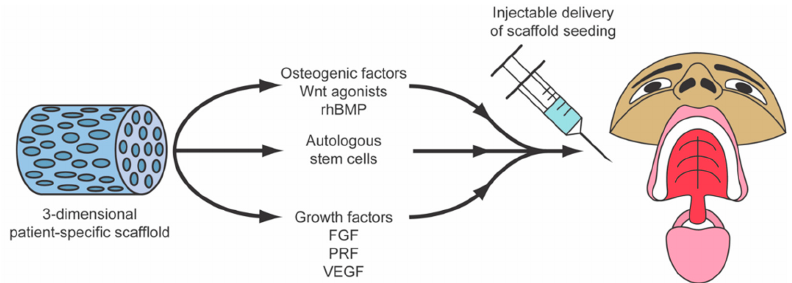
Figure 2. Combined application of osteogenic growth factors and cell-based therapies within biomimetic scaffolds for implantation in the craniofacial region. rhBMP, recombinant human bone morphogenetic protein.